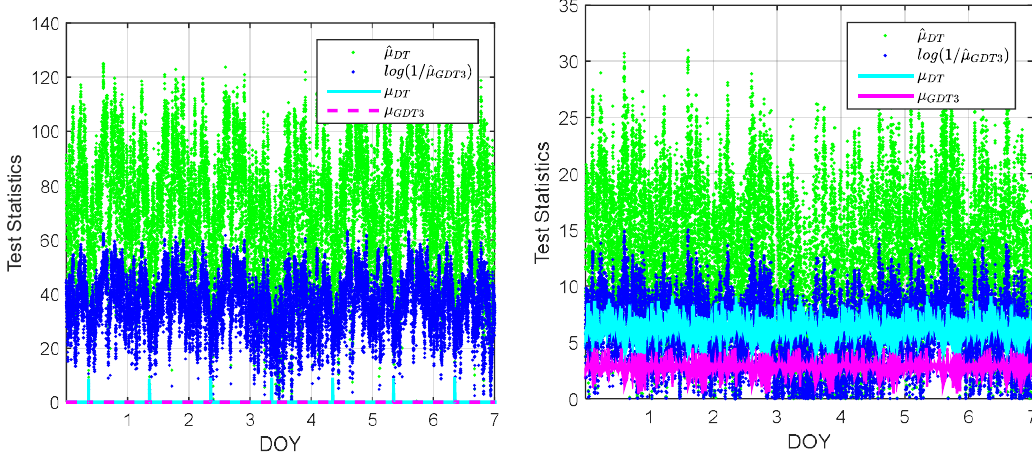
Figure 8 . Illustration of DTIA and GDT3 test statistics and FF-threshold for baseline P256-P259 (left) and P067-P259 (right).